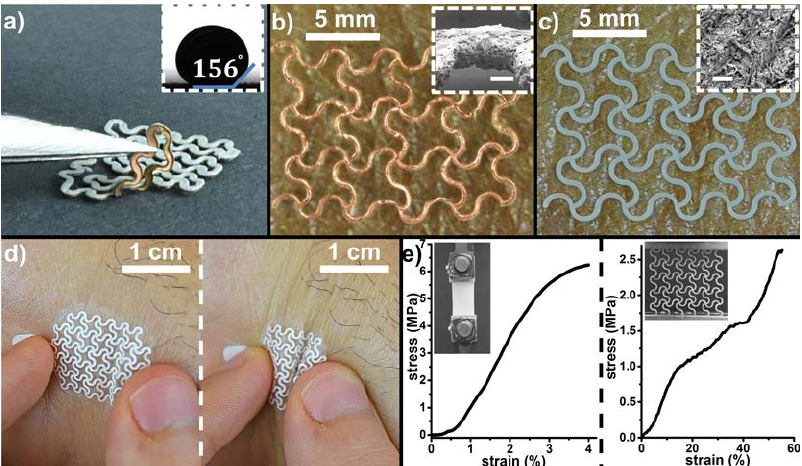
Figure 2. Razor printed EPEDs: ( a ) Omniphobic EPEDs comprising a thin conducting layer and a silanized paper serving as a back support. Inset shows the apparent contact angle of a 10 μL water droplet on top of the silanized paper substrate; ( b ) EPED on top of skin, with 20-μm-thick copper film as a conducting layer (copper facing up). The inset shows an SEM image of the 70-μm-thick patterned paper substrate (scale bar is 50 μm); ( c ) EPED with an 8-μm-thick layer of Ag/AgCl ink deposited on top of the omniphobic paper (Ag/AgCl facing up). The inset shows an SEM image of the Ag/AgCl/paper electrode, demonstrating that neither the functionalization of the paper nor the subsequent deposition of Ag/AgCl ink clogged the porous structure of the paper substrate (scale bar is 100 μm); ( d ) Conforming of EPEDs to skin bending and buckling due to severe compression; ( e ) Left: Representative stress-strain curve of an unpatterned paper substrate. Inset shows the experimental set up used. Right: Stress-strain curve of an Ag/AgCl EPED showing how the razor patterning of the EPED improves its stretching when compared to unpatterned paper. Inset shows the mechanical characterization of a representative EPED sample.